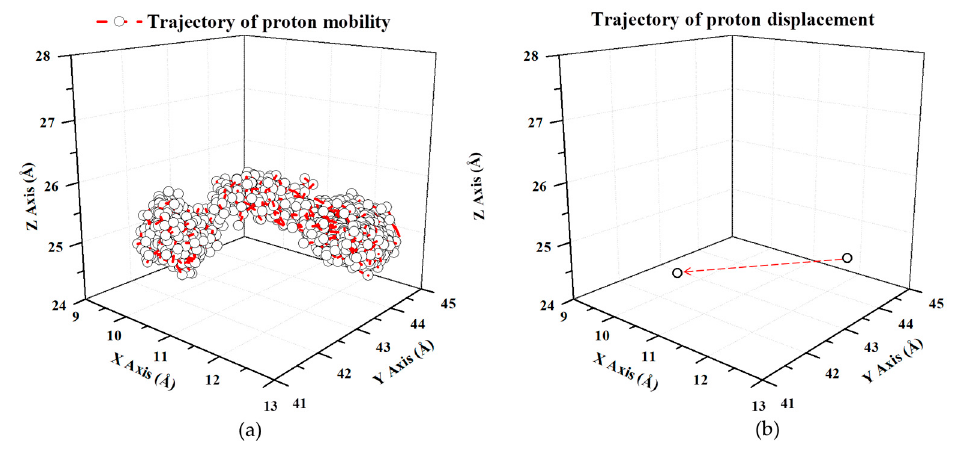
Figure 6. ( a ) The trajectory of a selected proton and ( b ) the displacement of a selected proton, over a simulation run.